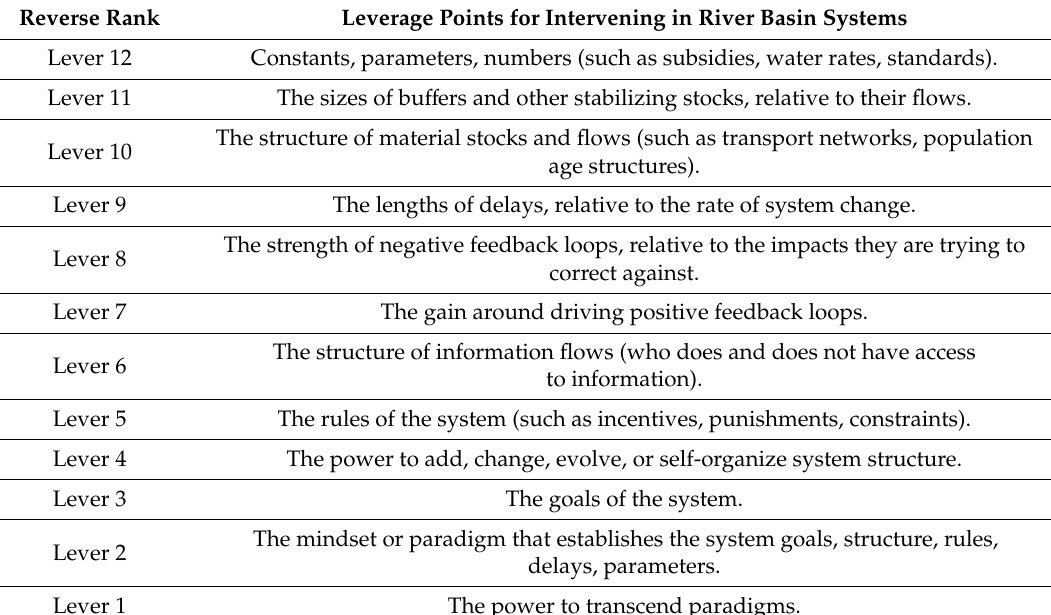
Table 1. Strategic leverage points for intervening in systems, such as river basin restoration, ranked from least to most e ff ective. Adapted from Meadows